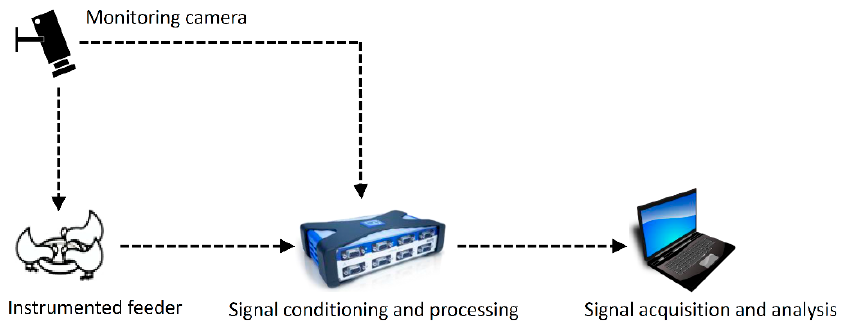
Figure 2. General scheme of signal conditioning and processing for data acquisition.